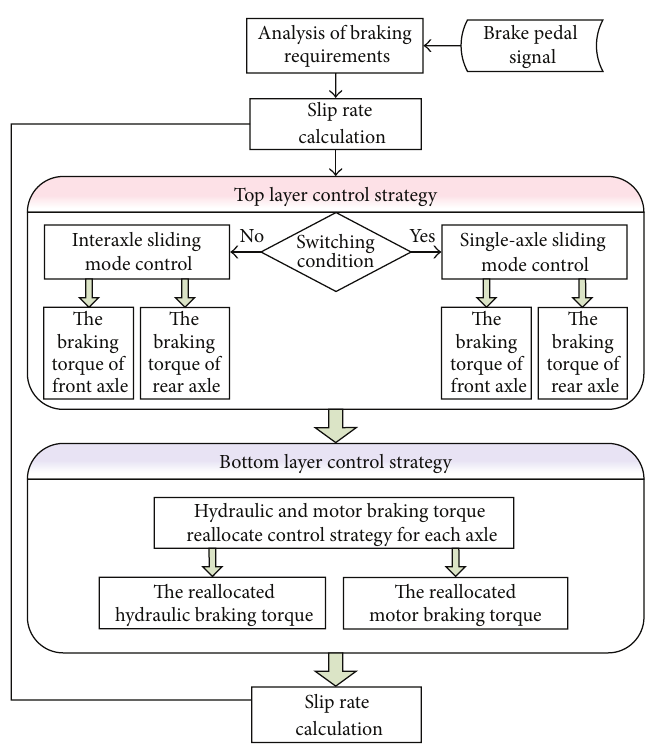
Figure 2: The hierarchical control